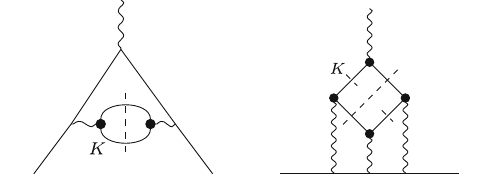
Fig. 10 DiagrammaticrepresentationofthekaoncontributionstoHVP (left) and HLbL (right). The thick black dots denote kaon electromag- netic form factor insertions. Dashed lines indicate the ¯ K K cuts and, for HLbL scattering, the kaon pole in the γ ∗ γ ( ∗ ) → ¯ K K subamplitudes